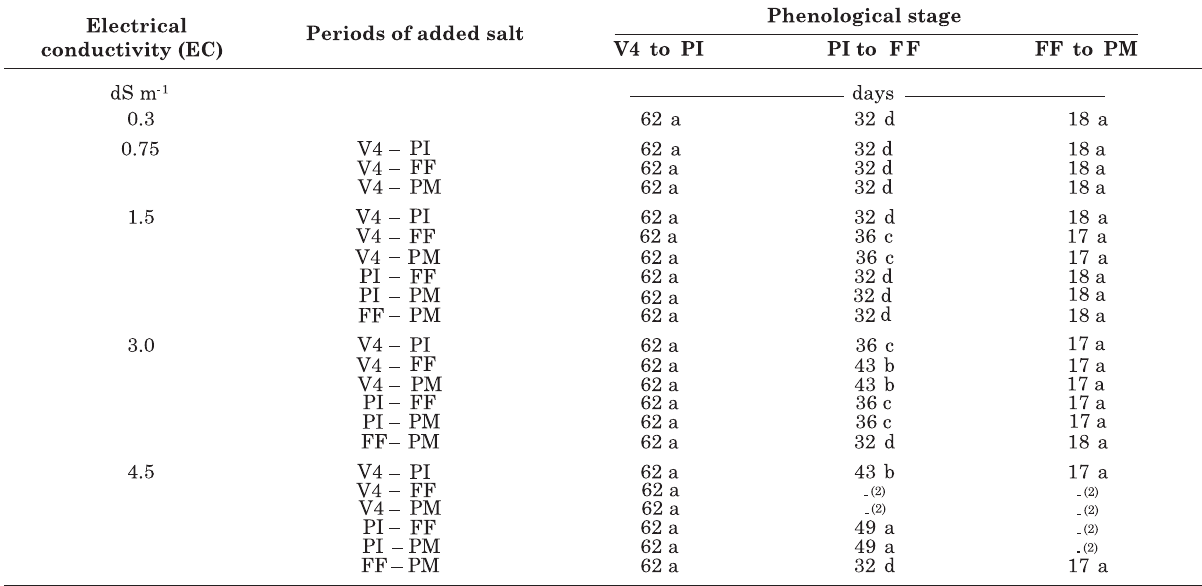
(1) Defined by the scale of Counce et al. (2000) - V4: four fully expanded leaves; PI: panicle initiation; FF: full flowering; PM: physiological maturity. (2) Not evaluated due to plant death. Means followed by the same letter in column do not differ by LSD test (p <